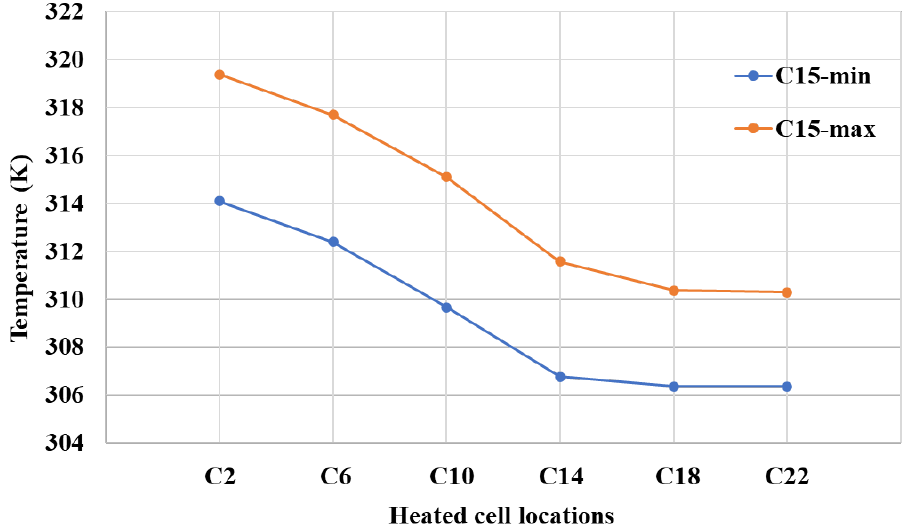
Figure 8. Temperature changes of cell 15 among the applied abnormal heat generation on different cells in Row 2.